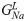
Interneurons from NTG mice exhibit action potentials with significantly higher mean amplitude as a function of stimulus strength as compared to those from APdE9 mice.Change in mean amplitude of all spikes in the time trace as a function of stimulus strength as we vary GNaL (a), Gh (b), and GNaF (c). Symbols and lines represent experimental and theoretical values respectively. Squares and triangles are for interneurons from NTG and APdE9 mice respectively. Error bars represent the root mean squared error.